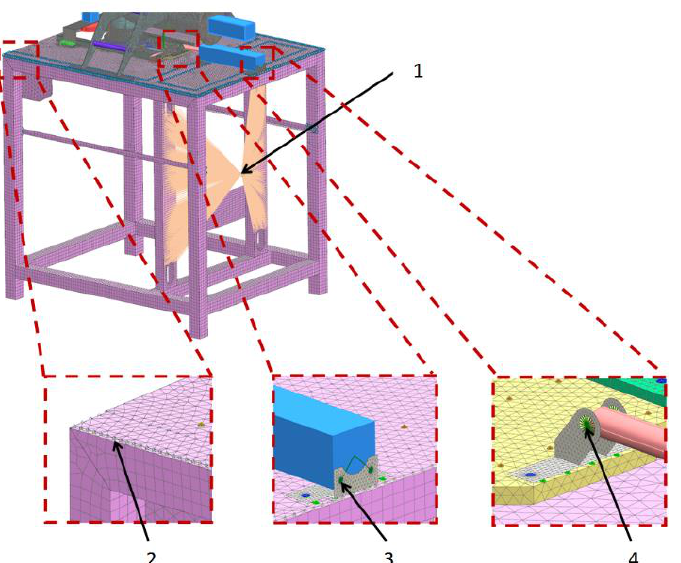
Figure 7. Calculation model of the forming module showing the way of modeling the welds and the actuator connection. 1. The method takes into account the weight of the control box to the mounting bracket: rigid elements are 1D (RBE2) and mass is of the “lumped mass” type. 2. Weld pattern: el. 1D (RBE2). 3. Connection of the actuator with the handle: el. stiff. 4. Connection of the actuator piston rod with the handle: rigid elements (RBE2).